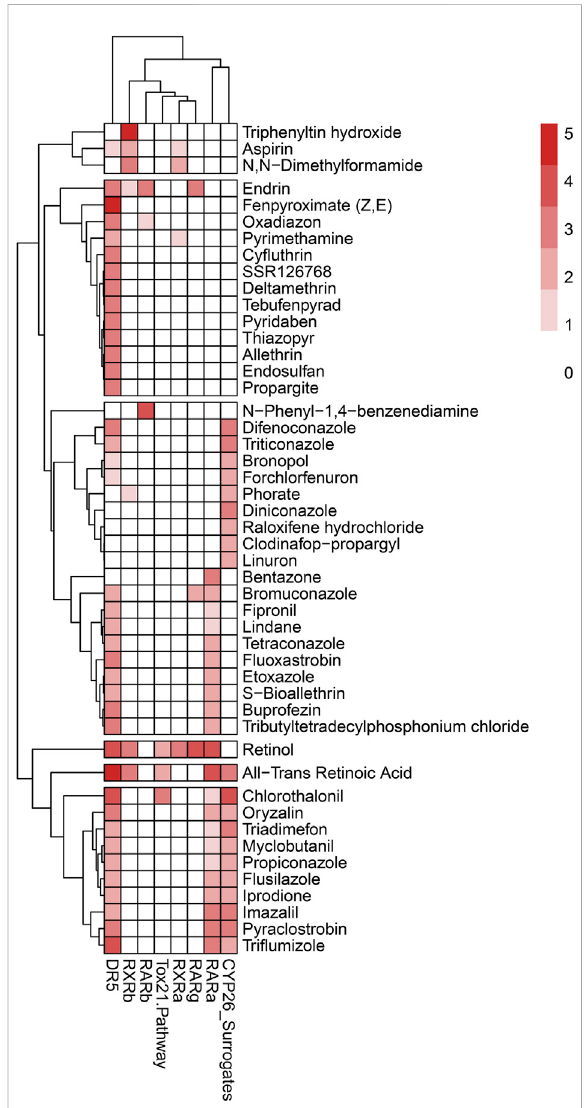
FIGURE 5 Heatmap dendrogram of 48 chemicals associated with ATRA pathway disruption andskeletaldefects inToxRefDB andToxCast/ Tox21 with potential AOP elucidation. Re fl ected are disruption activity of 8 targets of interest (RARA/B/G, RXRA/B, RSP (Tox21), DR5, and CYP surrogate biomarker). Scale of 0 – 5, with lightest color indicating less target disruption activity and darker red indicating higher target disruption activity compared to other chemicals for the respective targets. The dominance of activity at DR5, CYP surrogate biomarker, and RARA is consistent with k-means and hierarchical clustering diagrams; however, the heatmap attributes a greater amount of sensitivity of DR5 to chemicals of interest through the consistently darker red shading. CYP26 and RARA follow DR5 as the most disrupted of the ATRA signaling pathway